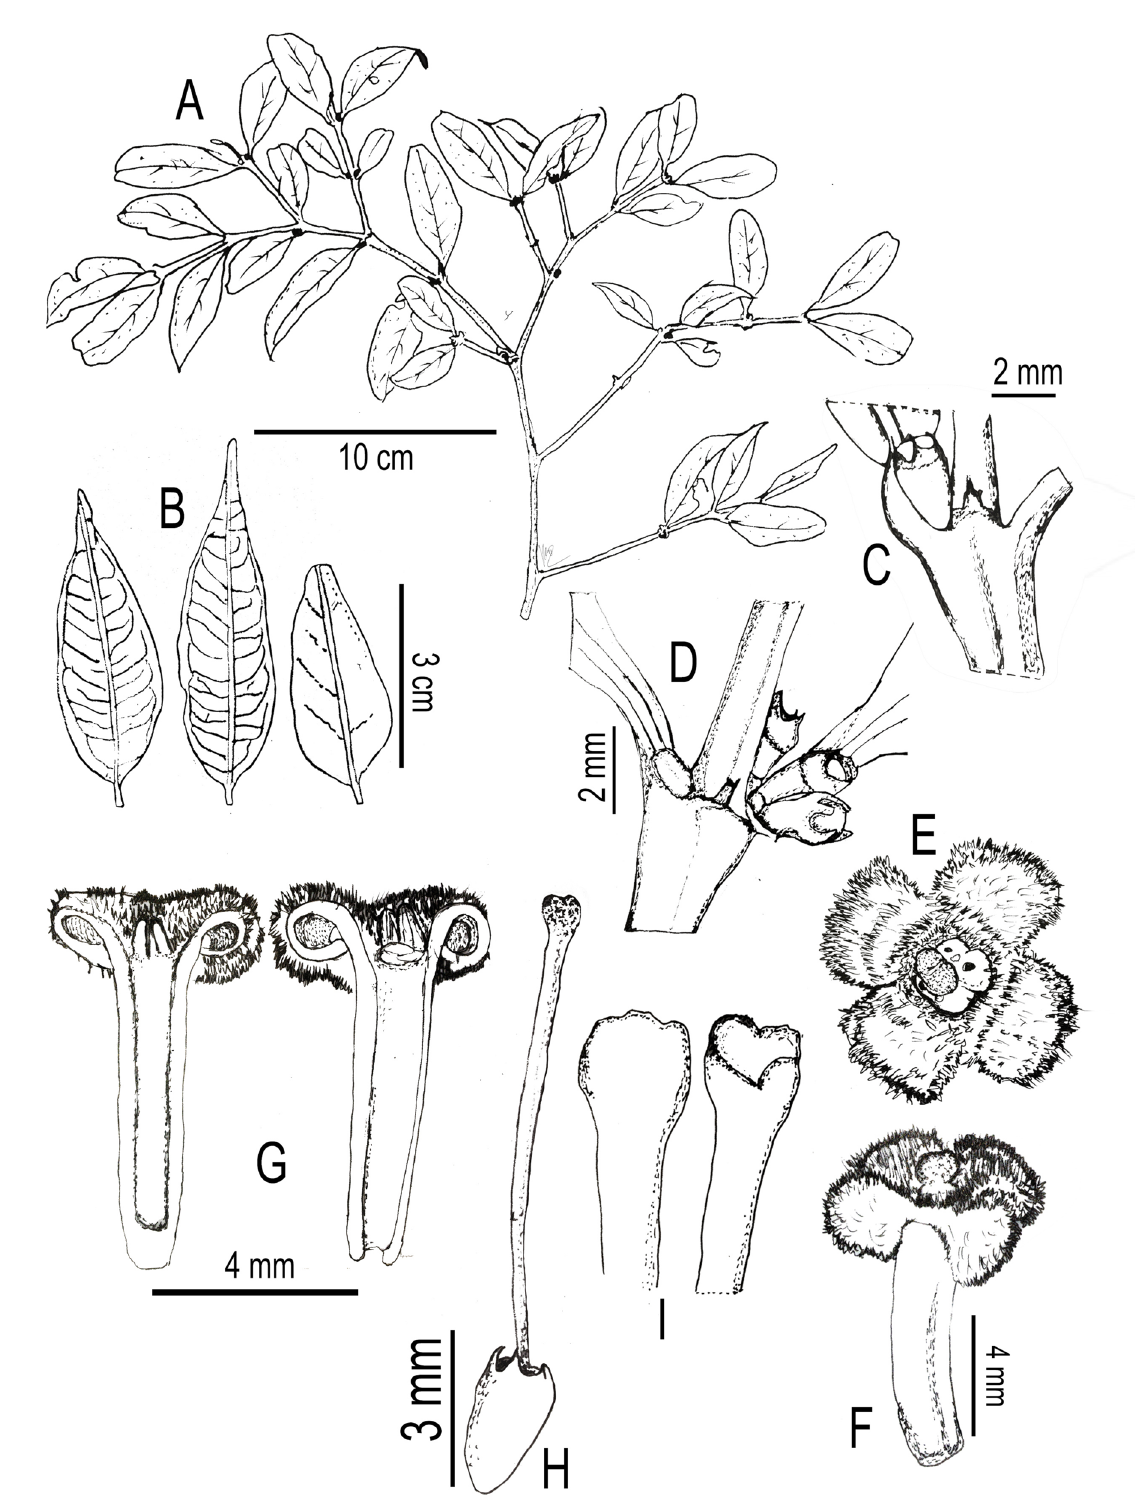
Fig. 5. Lasianthus sonlangensis V.S.Dang, Vuong & Quan sp. nov. A . Branch. B . Abaxial and adaxial leafs surfaces. C . Stipule and flower bud. D . Infructescence. E . Flower view from above. F . Flower in side view. G . Flower in vertical section. H . Stigma. I . Stigma apical portion. Line drawings from the holotype ( Dang 465 ) by Ba-Vuong